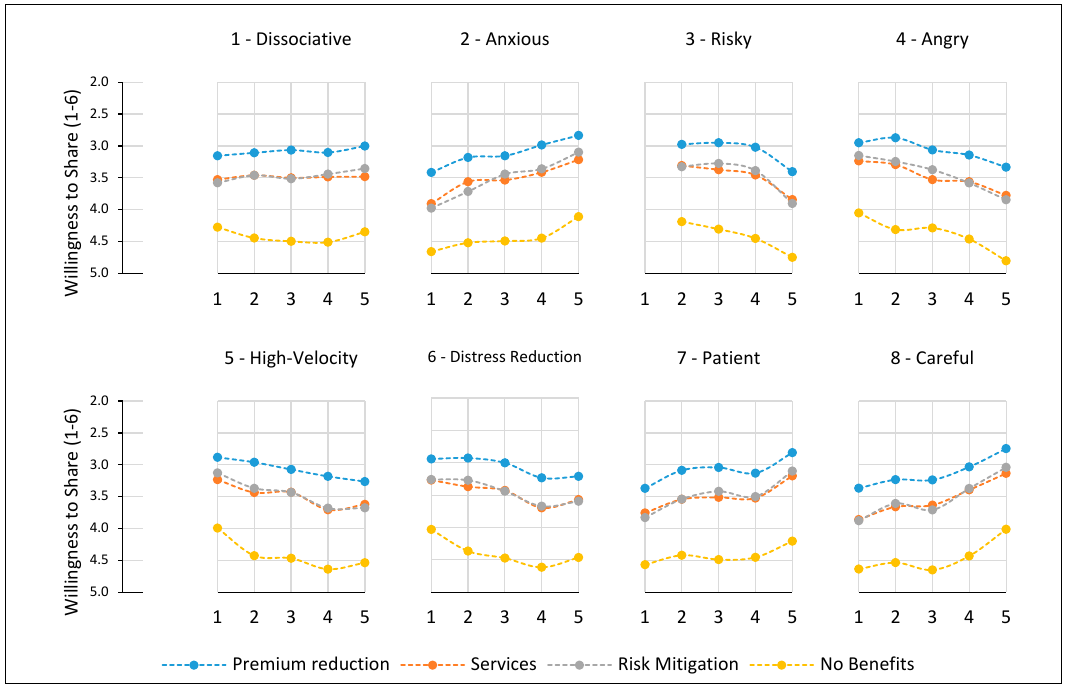
Figure 7. Impact of self-assessment quintile (1–5) on willingness to share information by benefit offered.